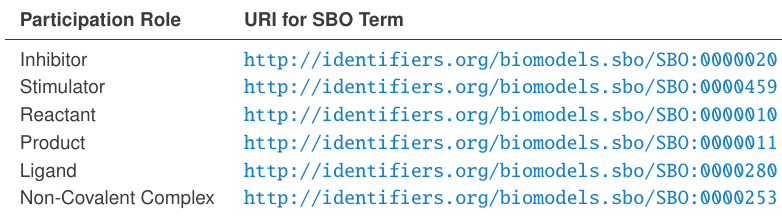
Table 12: SBO terms to specify the roles property of a Participation